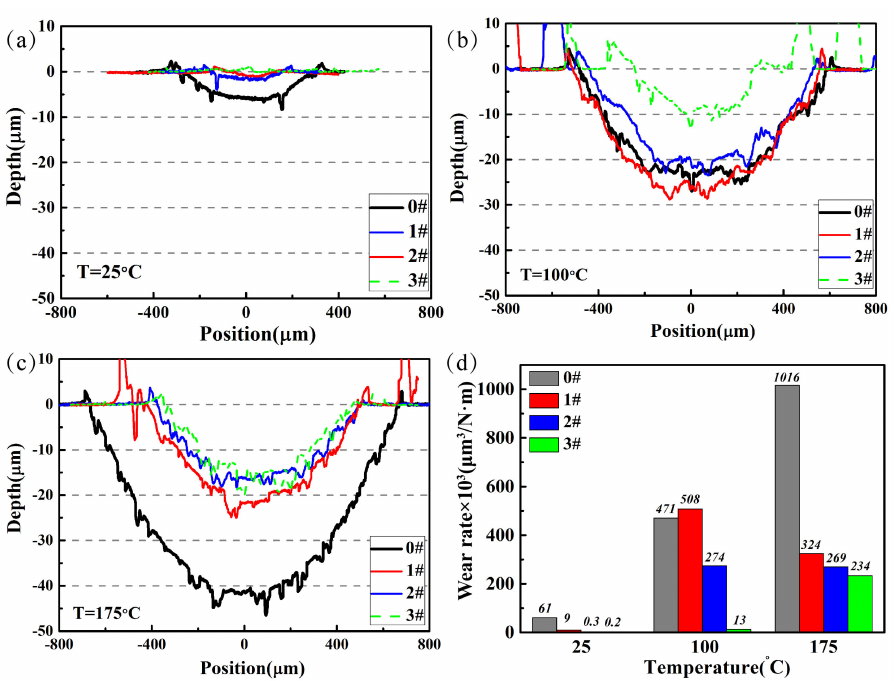
Figure 5. Cross-section profiles of the worn plates at varied temperatures: ( a ) T = 25 ºC; ( b ) T = 100 ºC; ( c ) T = 175 ºC; ( d ) wear rate of different samples at varied